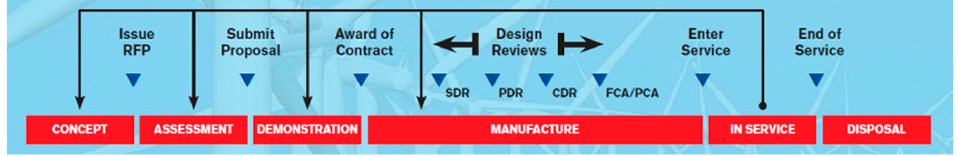
Figure 5. CADMID cycle: a product lifecycle model.